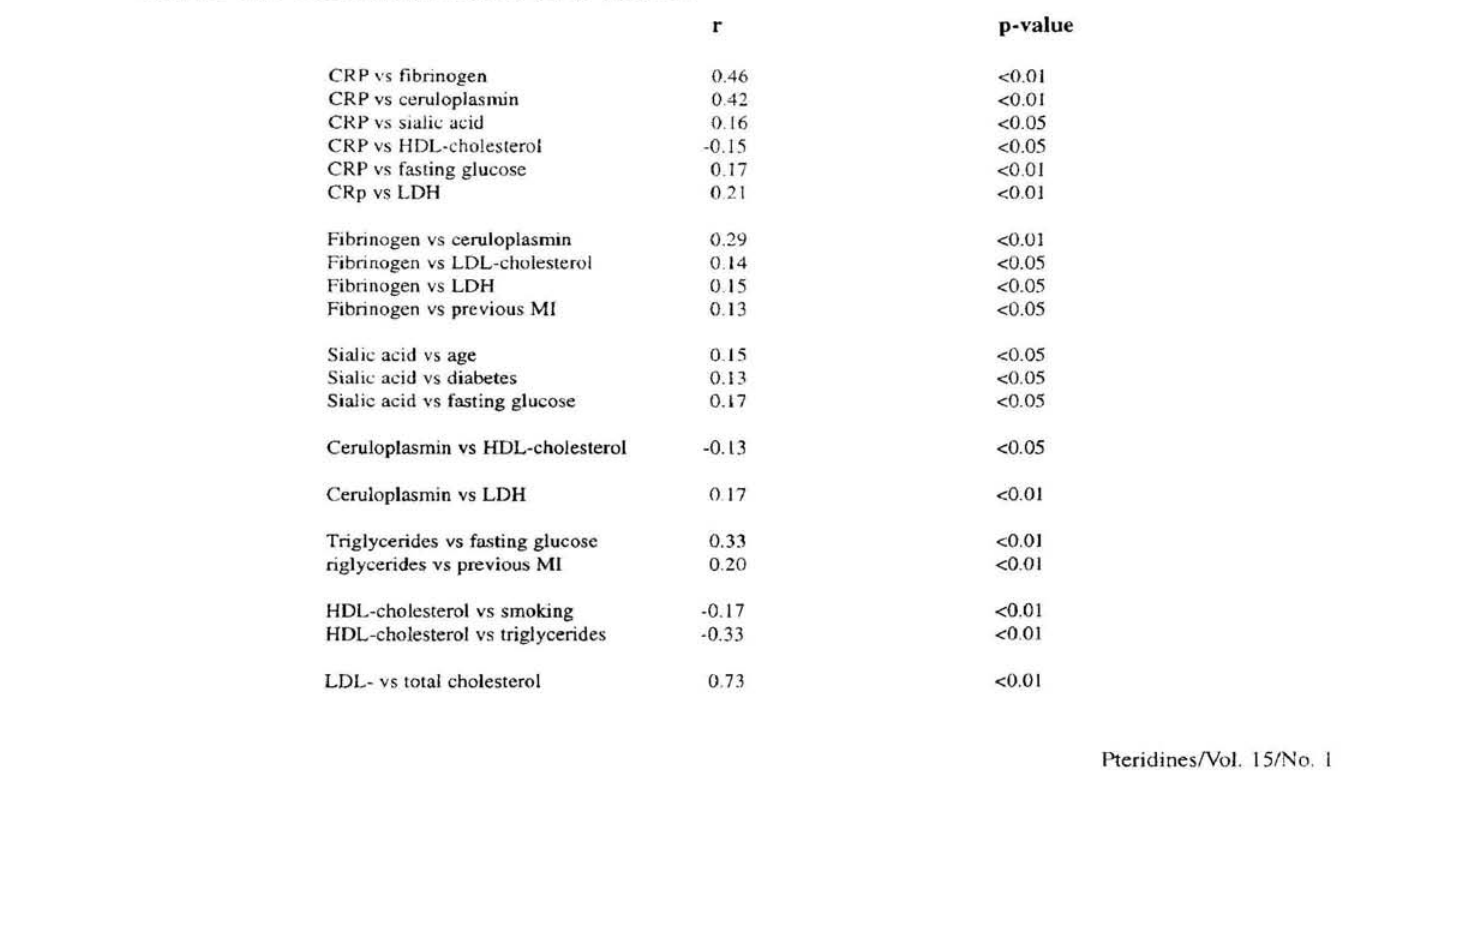
Table 4. Significant correlations within acute phase proteins, coronary artery disease (CAD) risk factors and between CAD risk factors and acute phase